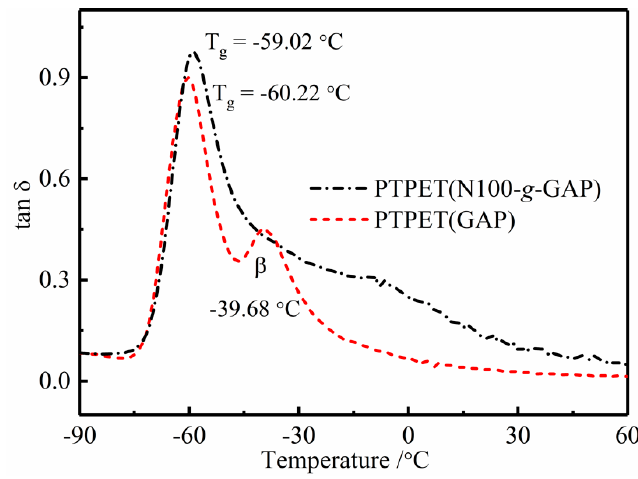
Figure 3. tan δ curves of the PTPET samples prepared by N100- g -GAP and GAP ( Mn = 4000 g/mol).